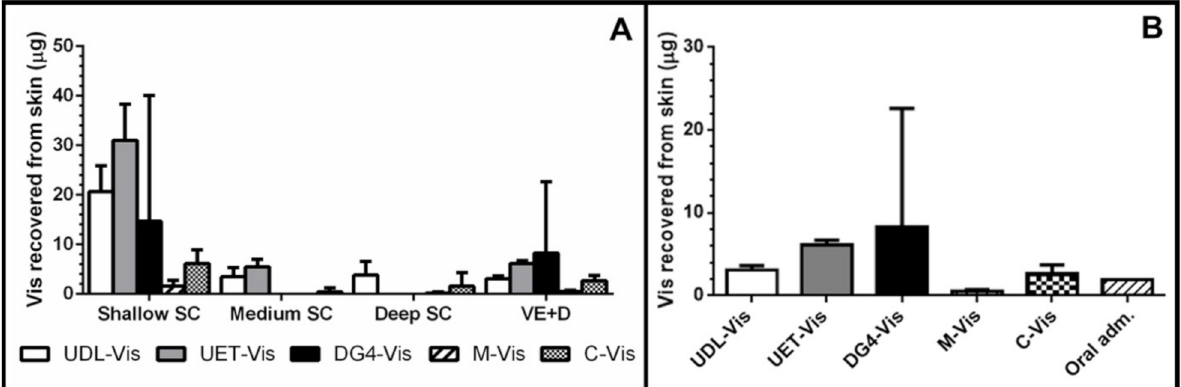
Figure 3. Human skin penetration. ( A ) Skin penetration profile of Vismodegib encapsulated in different drug-delivery nanosystems after 4 h of incubation on SPM. Mass of Vismodegib recovered from the shallow (tapes 1–5), medium (tapes 6–10), and deep (tapes 11–20) stratum corneum (SC) and viable epidermis + dermis (VE+D) are shown as mean ± SD ( n = 4). ( B ) Mass of Vismodegib recovered from the VE+D after 4 h of incubation with the different nanosystems compared to the theoretical mass of Vismodegib reached by conventional oral administration. The amount of Vismodegib yielded after the conventional administration was obtained from previous work [5]. Data are shown as mean ± SD ( n =